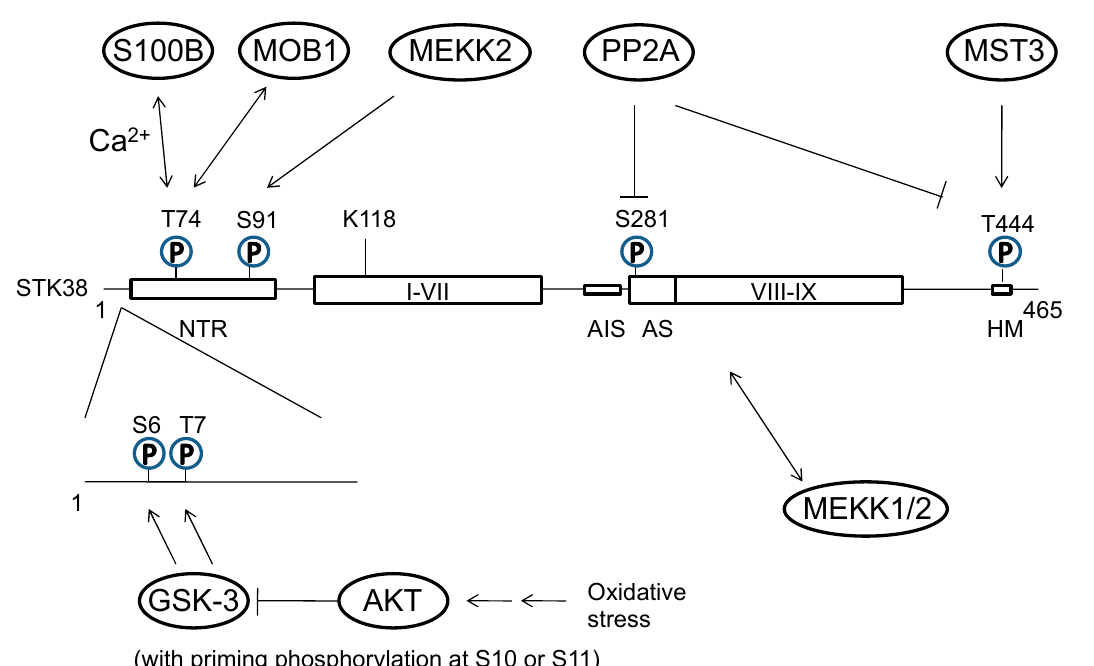
Figure 2. The regulation of STK38 by phosphorylation and protein–protein interactions. The regulatory region (NTR) at the N terminal of STK38 binds positive regulators such as MOB and S100B, which promote autophosphorylation (S281) and activation of STK38. Phosphorylatin of S6 and T7 at the STK38 by GSK-3 reduces STK38 activity. Upon activation of AKT (protein kinase B, PKB) by oxidative stress, GSK-3 is inactivated, which releases the negative regulation of STK38, resulting its activation. MEKKs (MEK kinases), which play essential roles in MAPK (mitogen-activated protein kinase) cascade and the oxidative stress-induced response, are negatively regulated by STK38 binding. MST-3 phosphorylates T-444 at the STK38 C-terminus and positively regulates STK38. Phosphoryla- tion of S91 by MEKK2 is critical for STK38 stability, as the enzyme is susceptible to degradation by the calpain pathway, only to be prevented by the phosphorylation of this